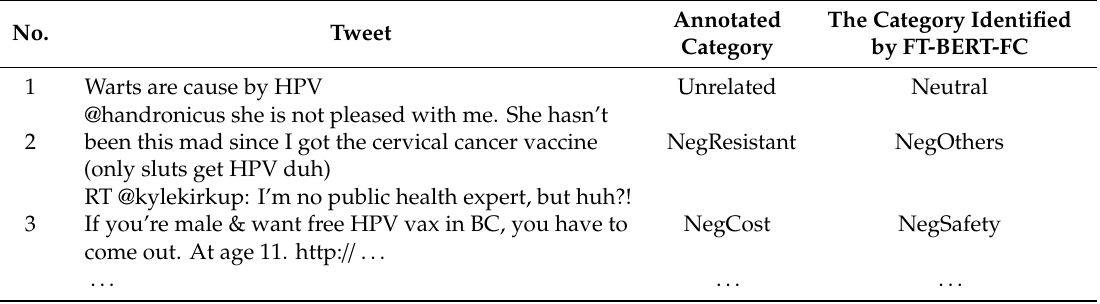
Table 7. Some tweets are not processed correctly by